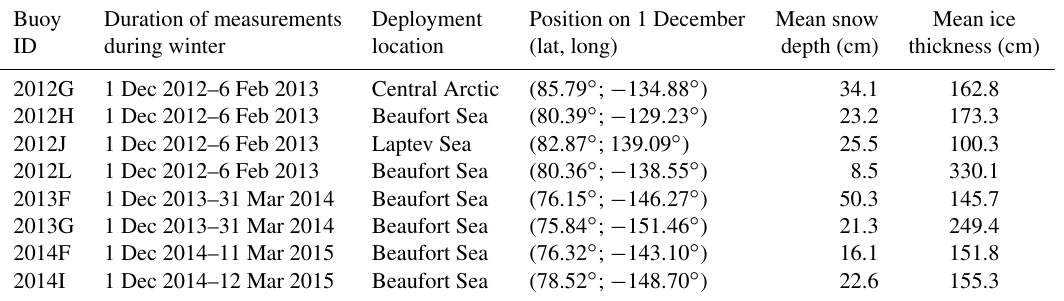
Table 1. List of the IMBs used in this study, with the mean snow depth (column 5) and the mean ice thickness (column 6) computed over the duration of the measurements (column